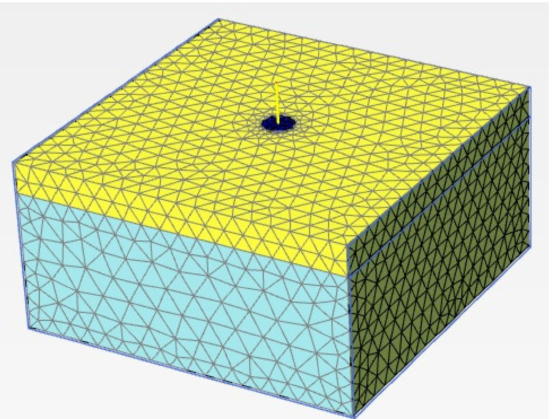
Figure 5. Three-dimensional FE model of the soil volume surrounding and underlining the exam- ined